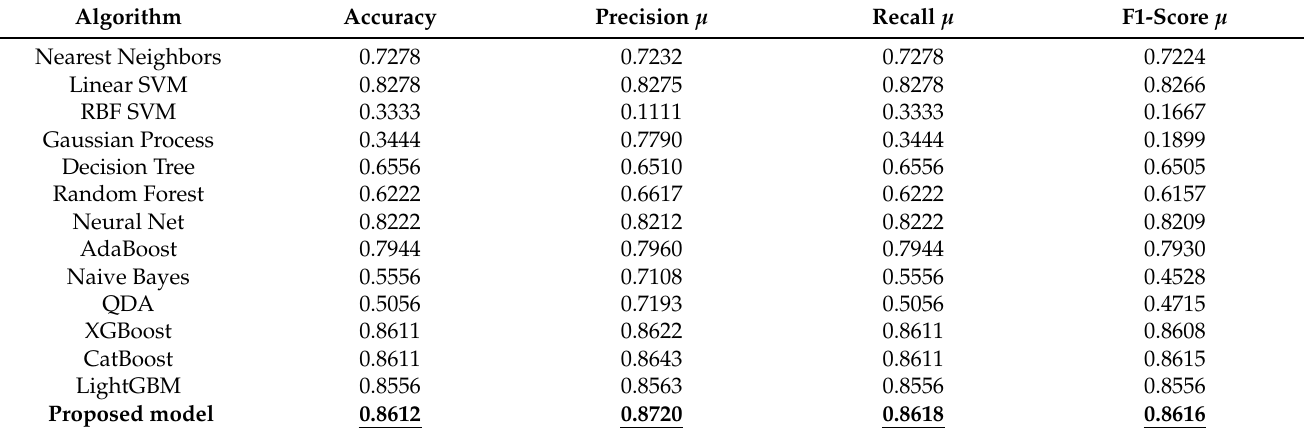
Table 6. Age classification of Fusaotome rice seeds.